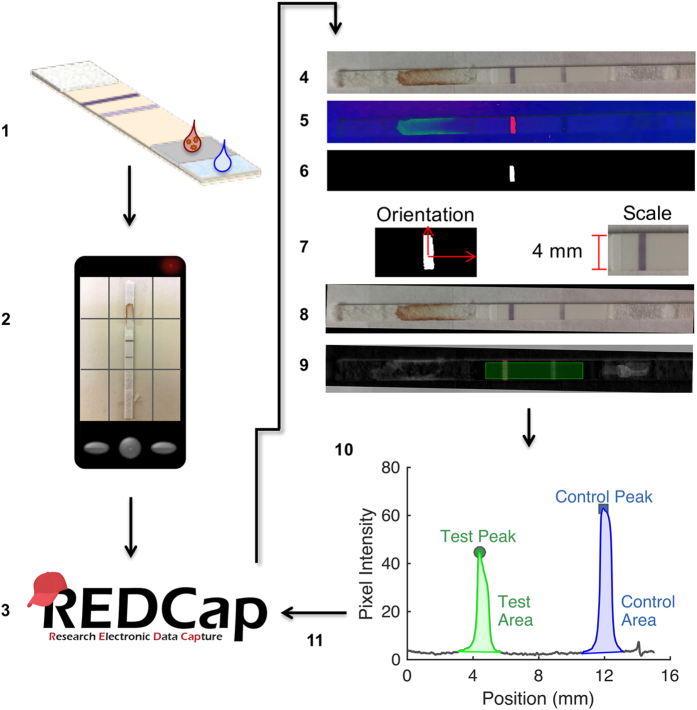
The diagnostic strategy workflow and image-processing algorithm.The REDCap logo is reproduced with permission from REDCap.